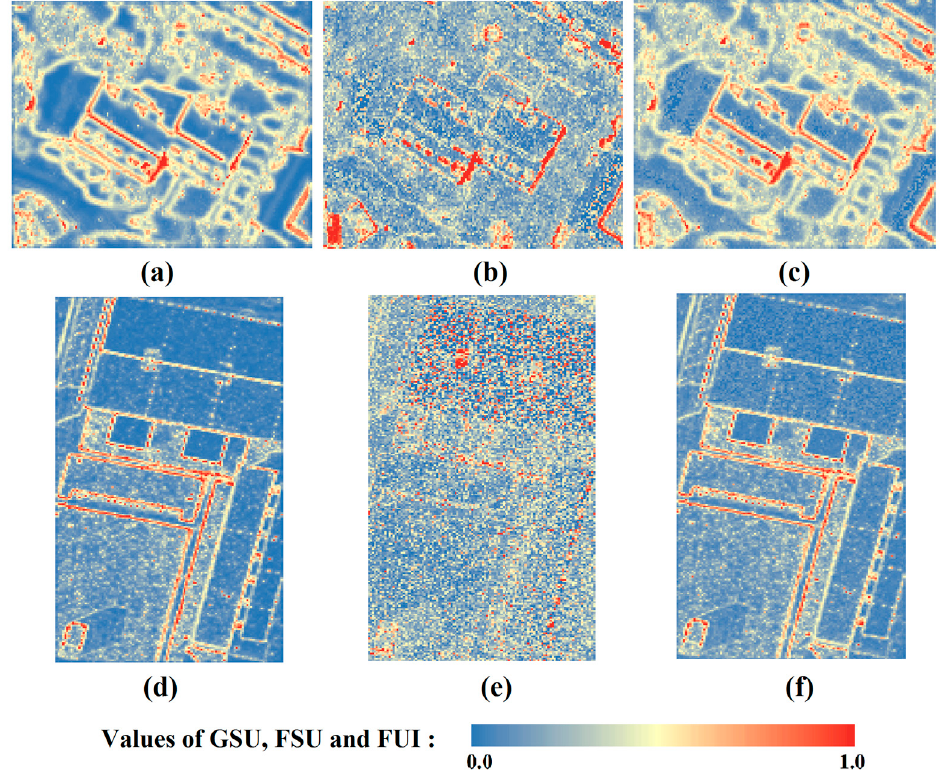
Figure 7. GeoSpatial Uncertainties (GSUs), Feature Space Uncertainties (FSUs), and Feature Uncertainty indices (FUIs) of Vaihingen and Potsdam images: ( a ) GSU of Vaihingen; ( b ) FSU of Vaihingen; ( c ) FUI of Vaihingen; ( d ) GSU of Potsdam; ( e ) FSU of Potsdam; and ( f ) FUI of Potsdam.